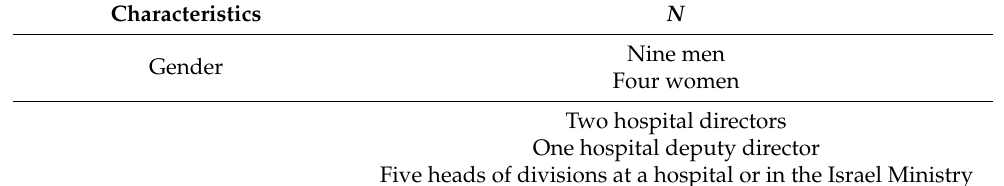
Table 1. Characteristics of